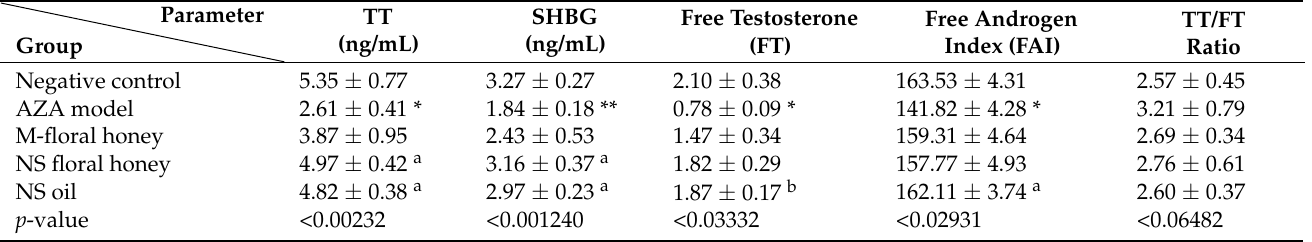
Table 2. Effects of M-floral honey, NS floral honey, and NS oil on testosterone hormone, SHBG, and related parameters.